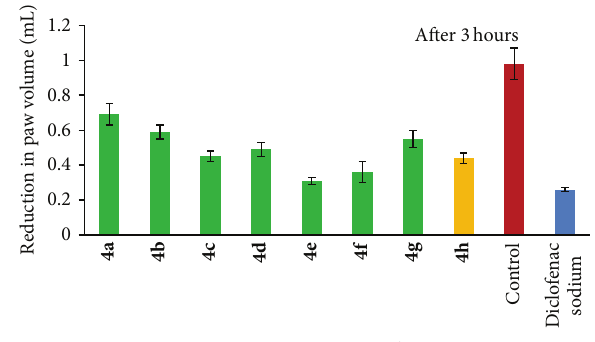
Figure 2: This histogram shows the inhibition of carrageenan- induced paw edema in rats. The histogram is plotted between target compounds ( 4a–h ) at 100mg/kg, control, standard drug diclofenac sodium (10mg/kg), on X axis, and reduction in paw volume on Y axis. Data has shown that the inhibition of paw edema significantly decreases by target compounds from control. Data are Mean ± S.E.M. indicates significant decrease in inflammation form control and indicates highly significant decrease, 𝑃 < 0.05 .